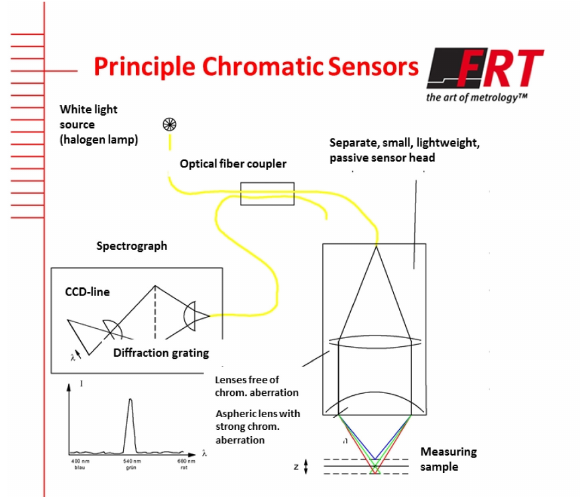
Fig. 2. Measuring principle of chromatic